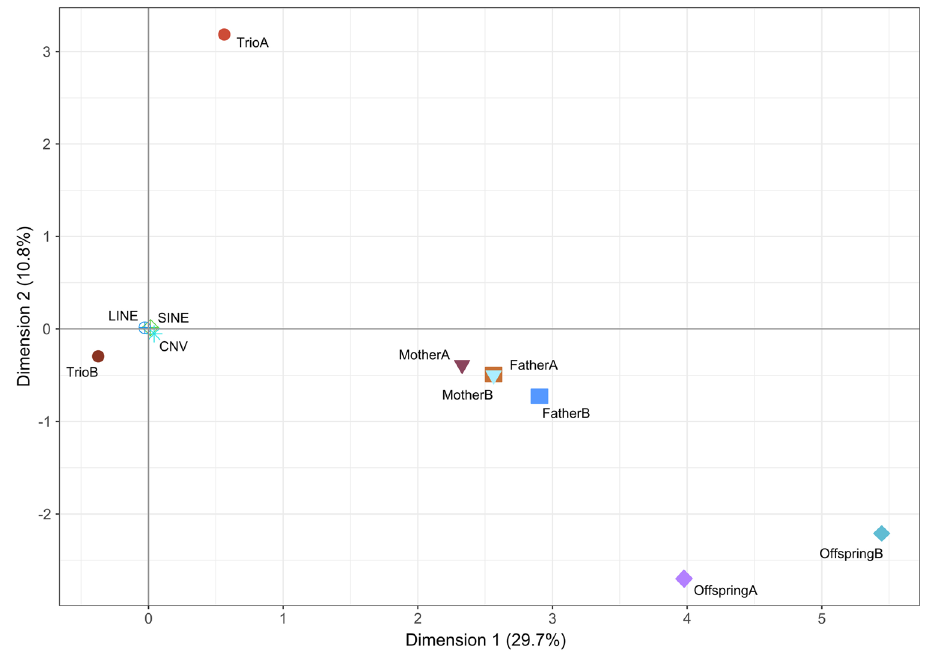
Figure 4. Dispersion plot constructed using the two canonical dimensions computed via corresponding analysis to illustrate the relationships between ME error classes, CNV, SINEs and LINEs. The Trio error classes are in circles, the Mother error classes are in triangles, the Father error classes are in squares, the Offspring error classes are in diamonds and CNV, SINEs and LINEs are in asterisks. Dimension 1 (on the X-axis) explained 29.7% of the variance and Dimension 2 (on the Y-axis)